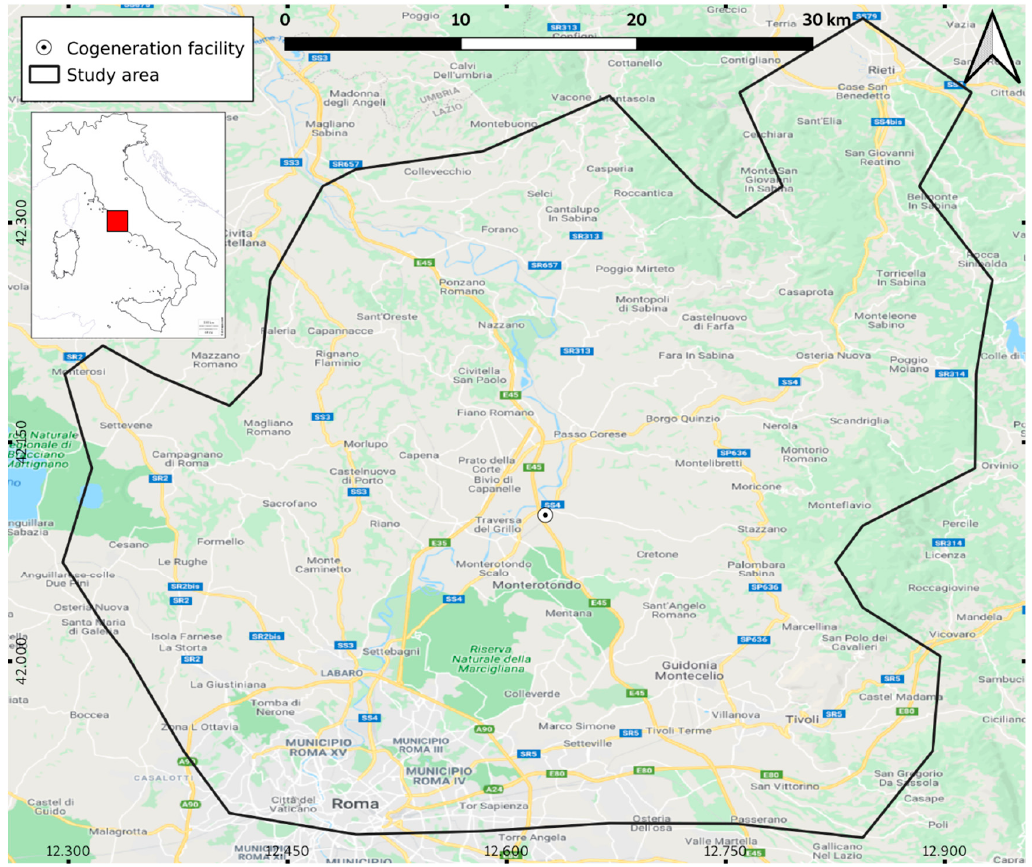
Figure 1. The geographical extent of the study area in Italy (inset). The cogeneration facility includes a combined heat and power plant located at the CREA-IT property. Road map from Google Maps. The Tiber River, which flows from the northern to southern side, cuts the area into two east– west regions approximately equally spaced. The eastern part overlaps the Sabine Hills, an area historically devoted to olive cultivation and the production of olive oil [25]. The western side overlaps a low-lying area mainly used for mixed farming, interspersed with ditches and small rivers where the natural deciduous forest vegetation is still conserved and historically known as the “Roman Campagna” (e.g., [26]). The Tiber River flows toward and in the city of Rome, whose urban settlements are included in the southern part of the study area.